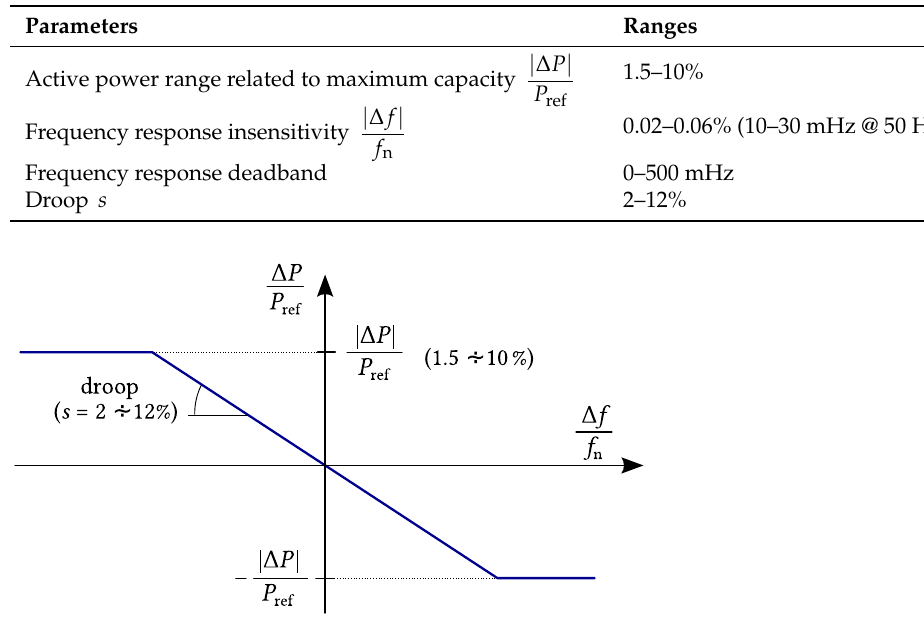
Table 1. Parameters for active power frequency response in Frequency Sensitive Mode, specified by the European Commission.